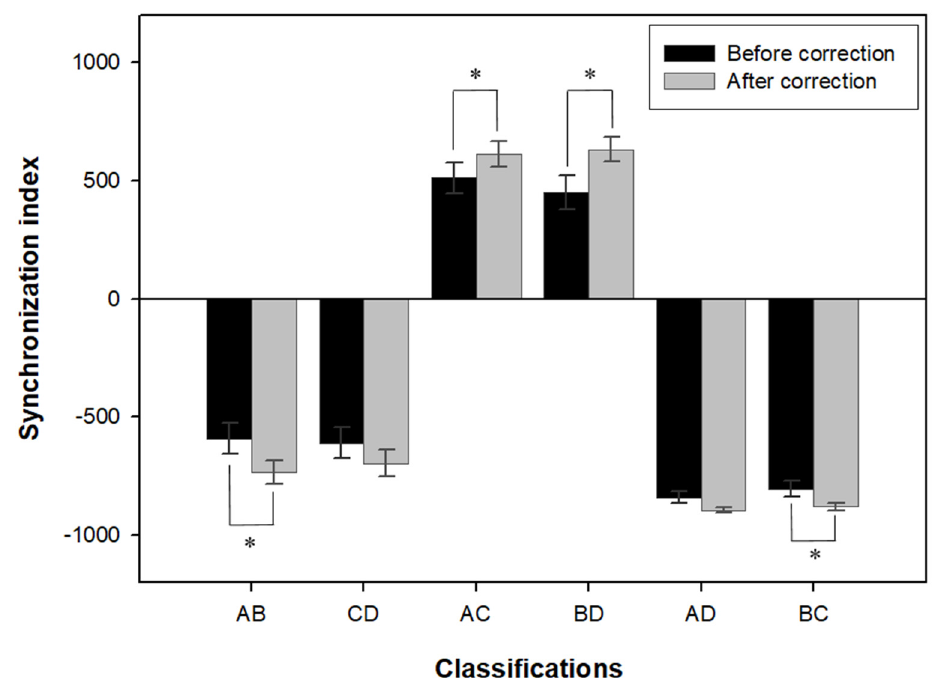
Figure 3. Changes in synchronization index before and after wearing corrective glasses in all participants ( n = 27). AB: entire left foot; CD: entire right foot; AC: left and right heels; BD: front parts of left and right soles; AD: left heel and front part of right sole; BC: front part of left sole and right heel. * p < 0.05 by paired t -test.